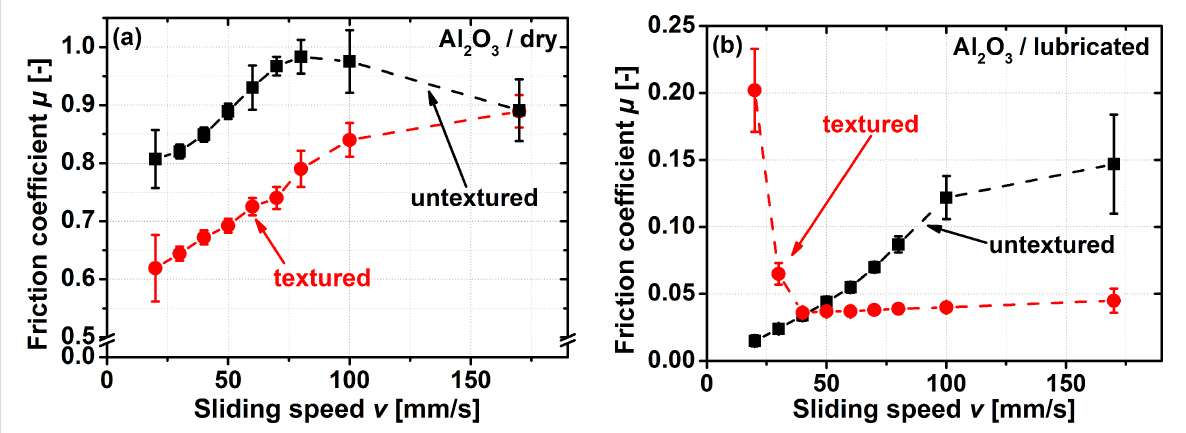
Figure 4: Stribeck curve-like pin-on-disc experiments for a variation in sliding speed from 20 to 170 mm/s for dry (a) and lubricated (b) steel-on- ceramic contacts. The normal force was 2 N during all experiments.